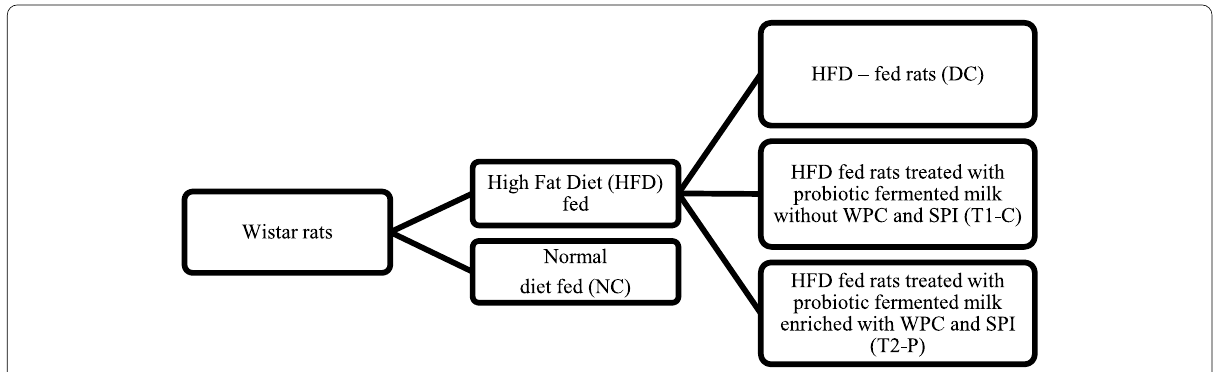
Fig. 2 Experimental design fed for Wistar